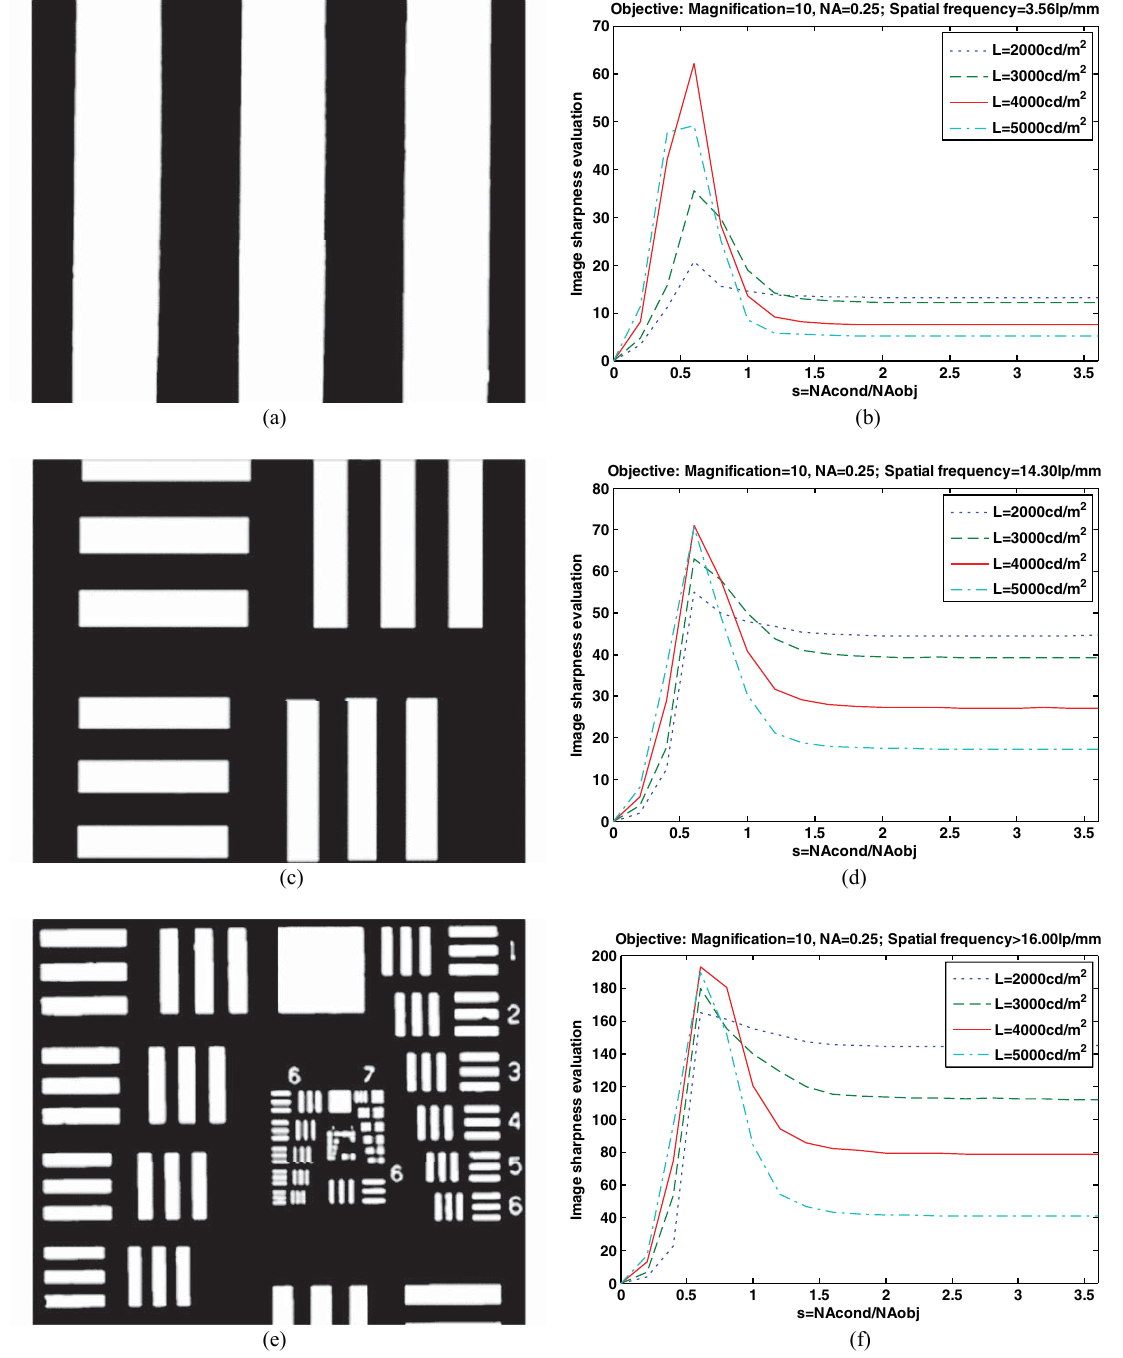
Fig. 4. The image sharpness measurements under 10 × (dry, NA obj = 0 . 25) with illumination intensity in the rangeof L=2000–5000cd/m 2 ; the L subjects to various systems; (a) f = 3.56lp/mm; (b) the measuring results of (a); (c) f = 14.30lp/mm; (d) the measuring results of (c); (e) f > 16.00lp/mm; (f) the measuring results of